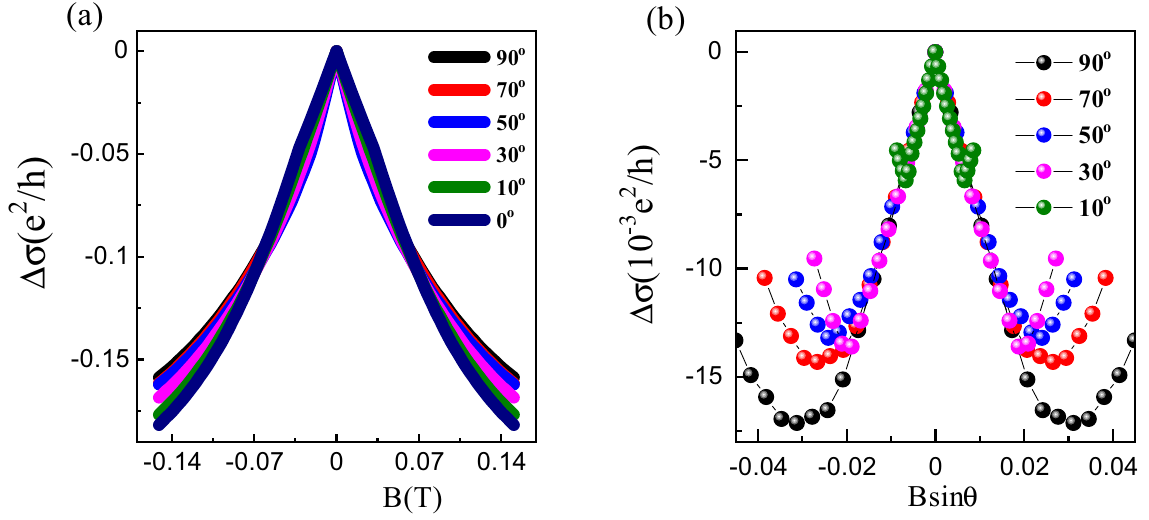
2 K measured with the field B applied at various angles θ σ ) at T △ =